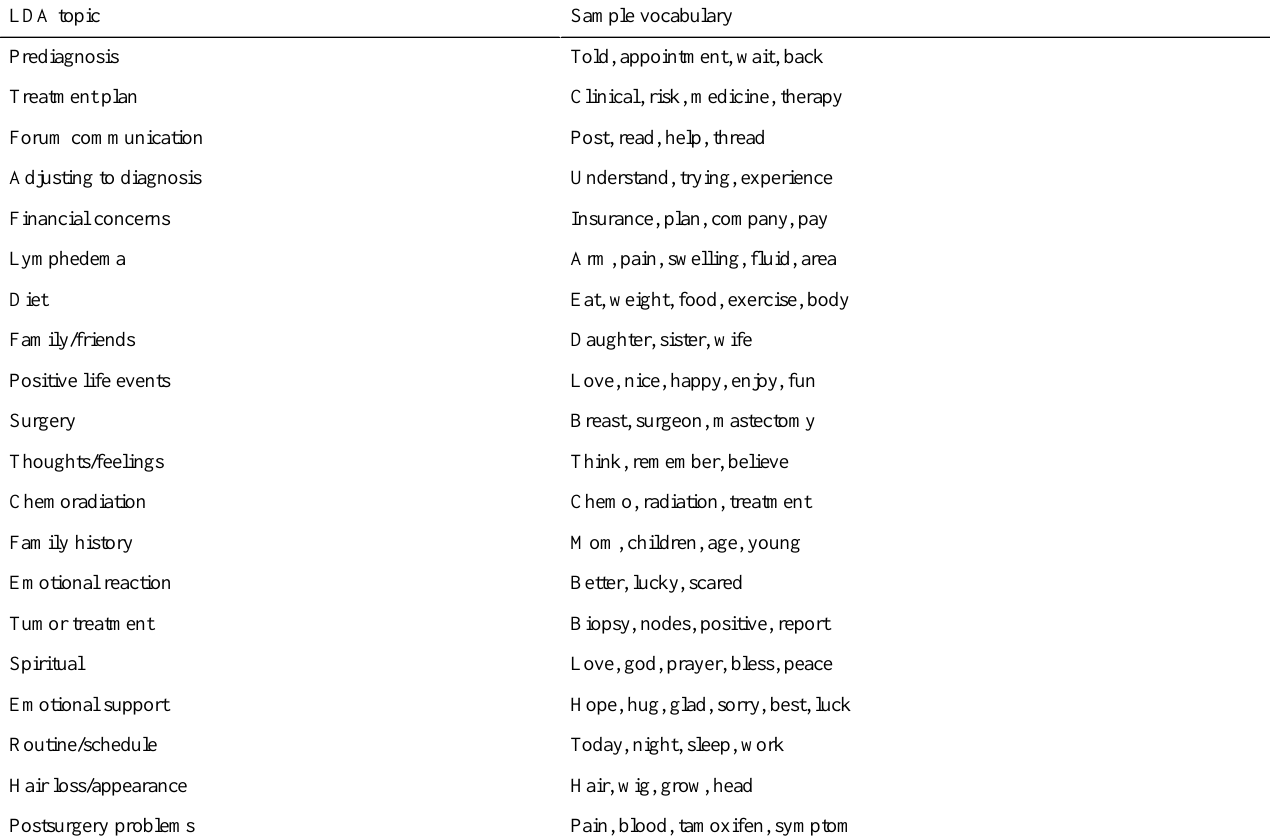
Table 3. Samples of vocabulary in latent Dirichlet allocation (LDA) topic dictionaries.